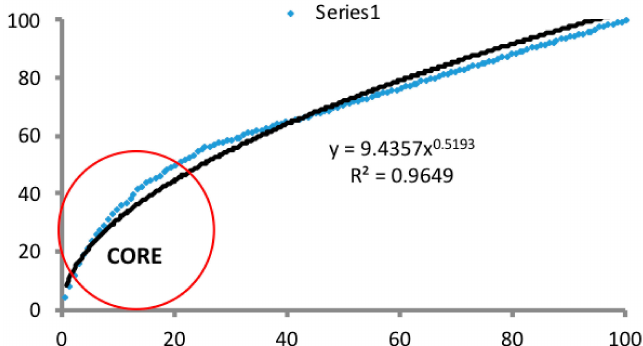
Figure 6. Lorenz curve. Bradford’s core of the most productive magazines Source: The authors’ own